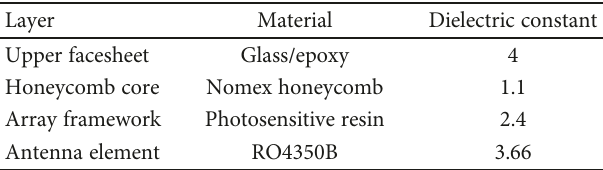
Figure 2: Structural con fi guration of antenna skin. Table 2: Electrical properties of every